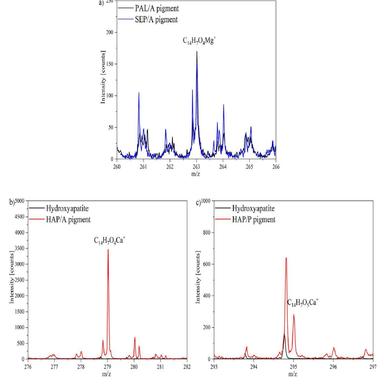
ToF-SIMS mass spectra of hybrid pigment samples: (a) PAL/A and SEP/A, (b) HAP/A, (c) HAP/P.